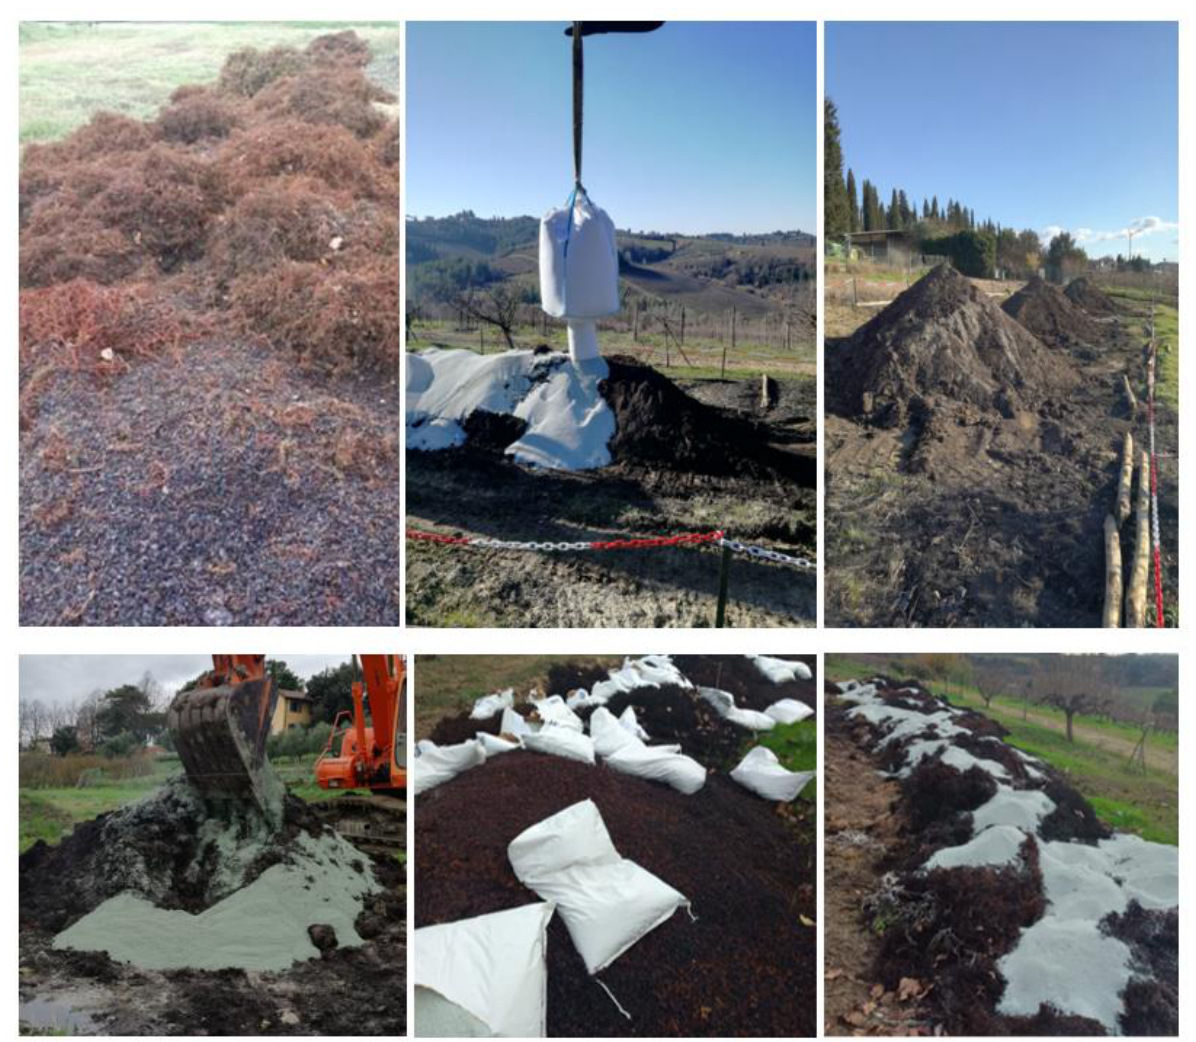
Figure 14. Composting cycle at CMM.